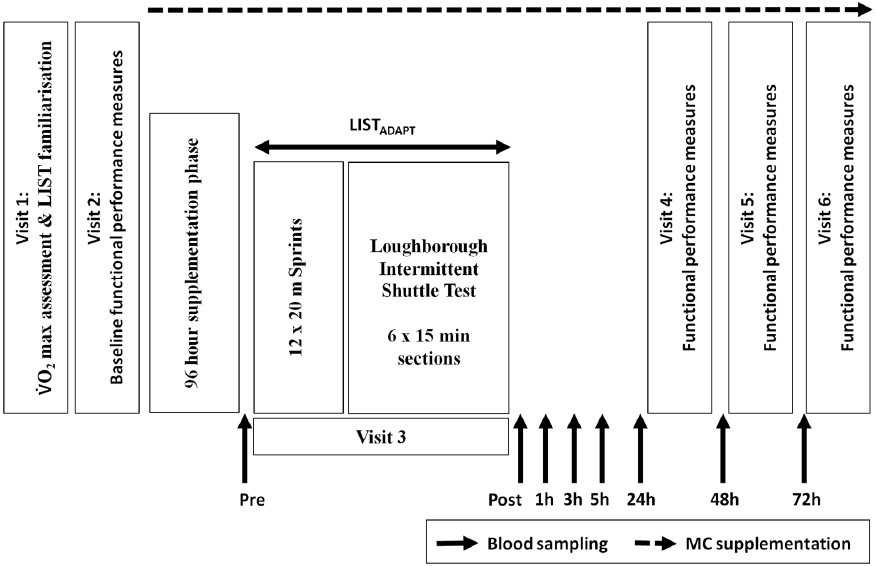
Figure 1. Timeline of study protocol including visit requirements, sampling point and supplementation